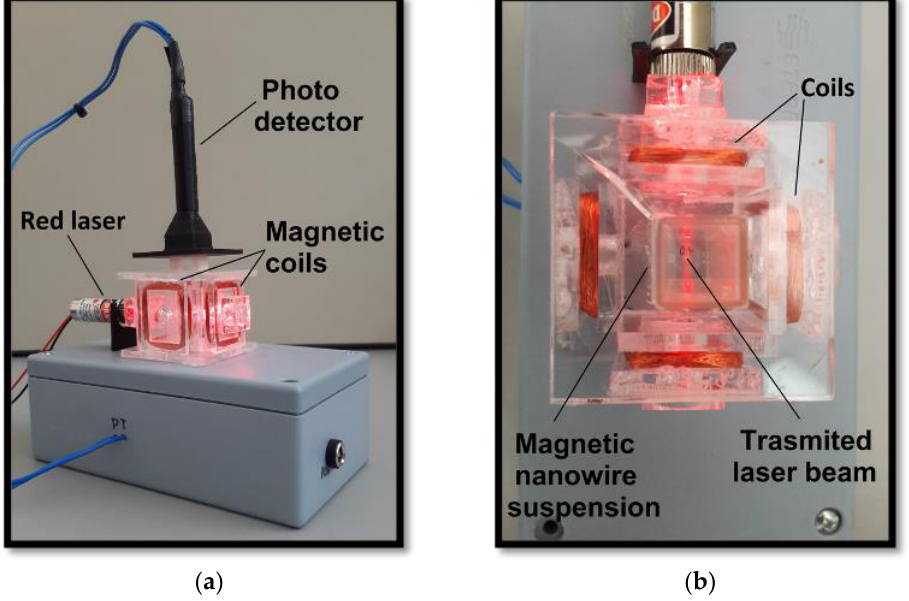
Figure 2. The experimental device designed to detect magnetic particles: ( a ) photo of the ensemble, ( b ) top view showing the laser light scattering caused by the NiNWs ’ rotation.